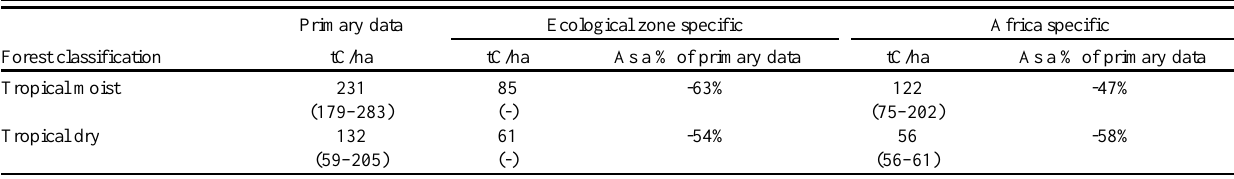
Table 4 . Comparison of primary data from this study with secondary above-ground forest carbon stock data, by forest type, showing the discrepancy between forest carbon stock methods (tC/ha). Secondary data sourced from IPCC (2006); note that the ecological zone data have only a point